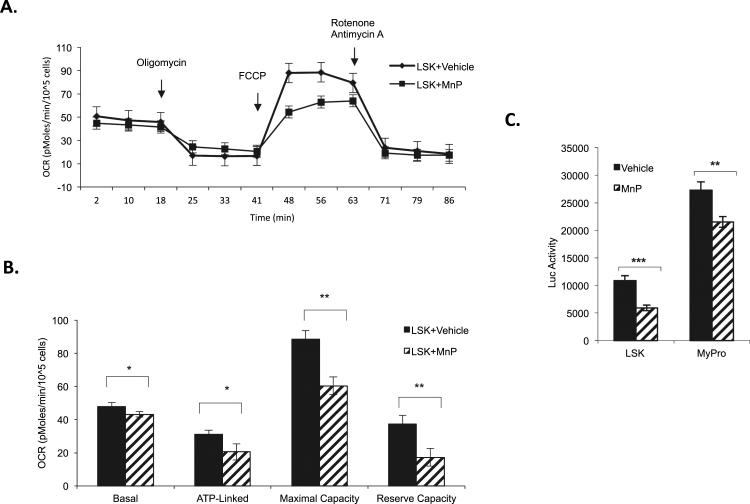
MnP inhibits mitochondrial oxidative phosphorylation and ATP production in LSK. A. The raw data of oxygen consumption rate (OCR) of Seahorse analysis on LSK cells. LSK cells were isolated and treated with vehicle or 20 μM MnP (MnP) for 2 h at 37 °C in 5% O2 incubator. The cells were then harvested, immunostained, flow cytometry sorted, and seahorse analyzed in the presence of the mitochondrial inhibitors (Oligomycin, 1 μg/ml, FCCP 1 μM, or Rotonone 1 µM and Antimycin 2 µM). B. The quantitation of basal, ATP-linked, the maximum, and the reserve capacity of oxygen consumption rate of panel A (n=3). C. The freshly isolated bone marrow cells were treated with either vehicle or 20 μM MnP (MnP) for 1 h, immune-stained and sorted. Equal amounts of cell lysate of LSK and MyPro cells were analyzed for ATP production cells (n>6). Data represent the mean+SD of at least three independent experiments.